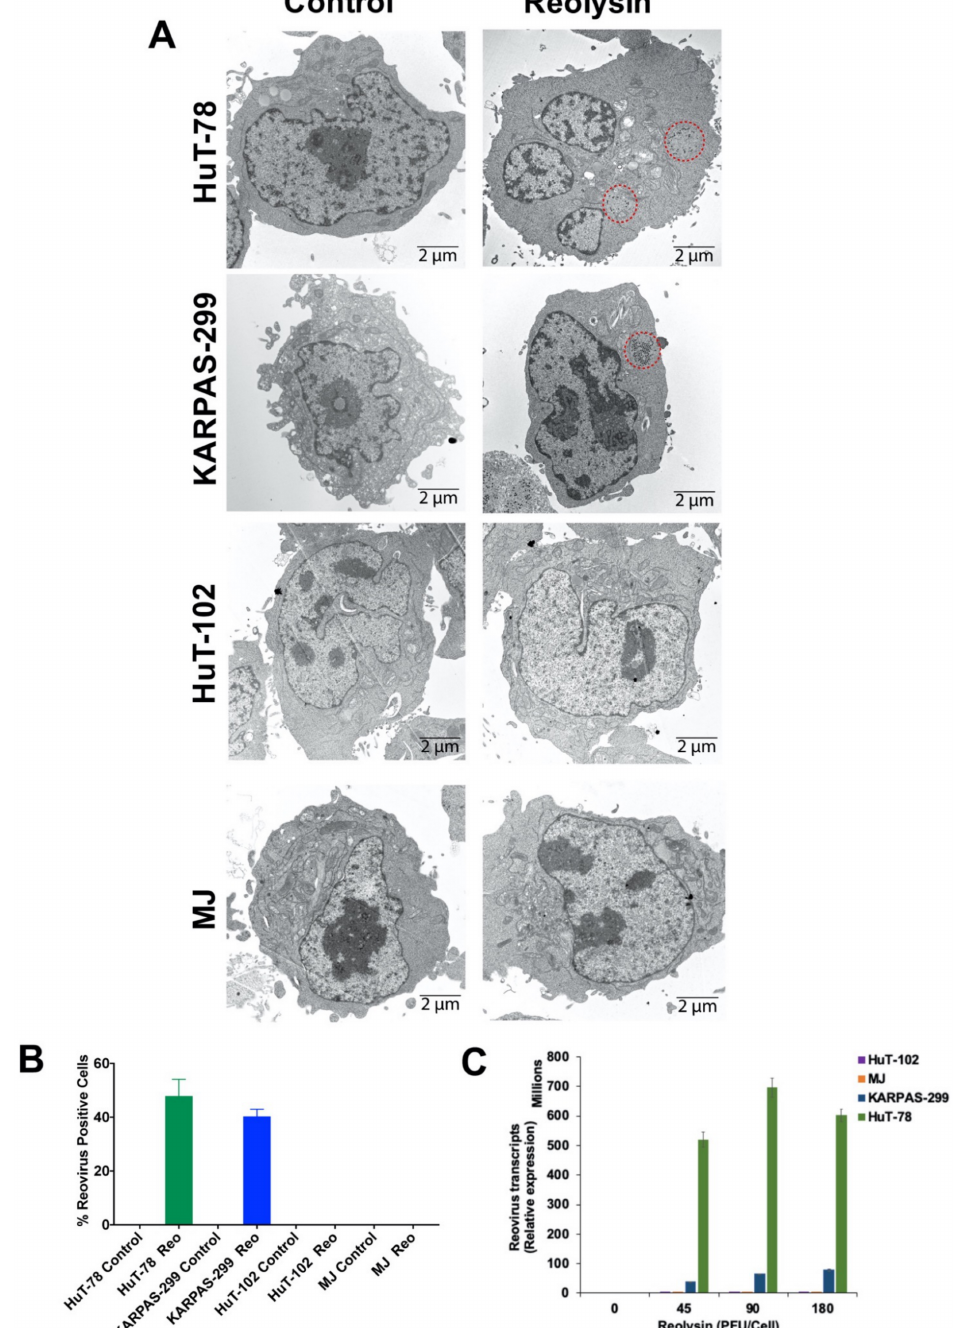
Figure 2. HuT-78 and KARPAS-299 TCL cells are sensitive to oncolytic reovirus replication. ( A ) On- colytic reovirus replicates in HuT-78 and KARPAS-299 cells. HuT-78, KARPAS-299, HuT-102 and MJ cells were treated with 90 PFU/cell Reolysin for 48 h. Reovirus accumulation was visualized by transmission electron microscopy. Red circles indicate reovirus accumulation. Representative images are shown. ( B ) Quantification of reovirus in TCL cells. The percentage of reovirus-positive cells was counted in approximately 200 cells per cell line using transmission electron microscopy. No reovirus- positive cells were observed in the HTLV-1-positive HuT-102 and MJ cell lines. Mean ± SD. ( C ) Quan- tification of reovirus transcripts by qRT-PCR. TCL cell lines were treated with the indicated con- centrations of Reolysin for 48 h. Relative levels of reovirus were determined by comparing 48 h Reolysin-treated samples with Controls for each cell line by qRT-PCR. Mean ± SD, n =